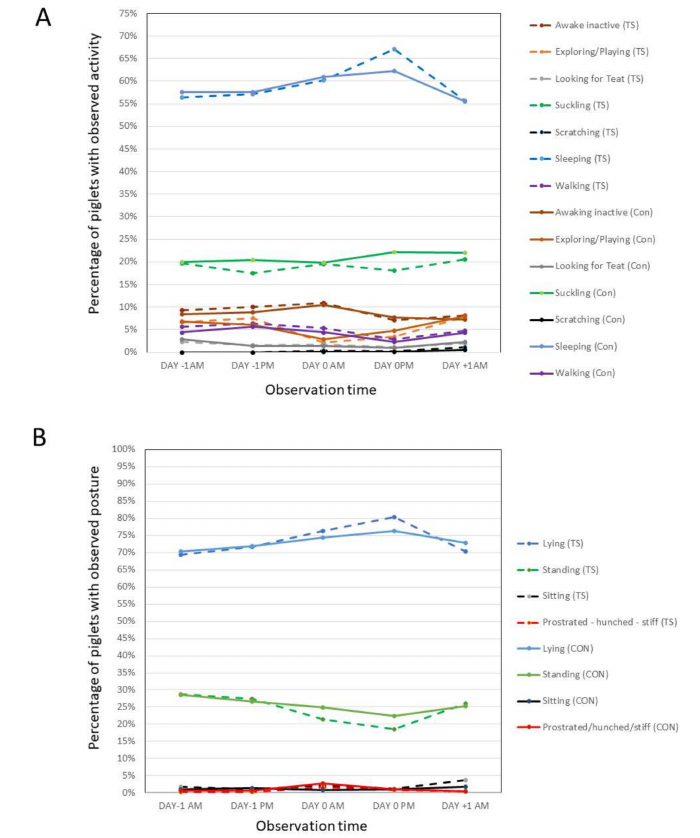
Figure 4. Results of scan assessments showing proportion of piglets ( A ) observed in different activities ( B ) observed in different postures in untreated control (CON) and Tri-Solfen (TS) treatment